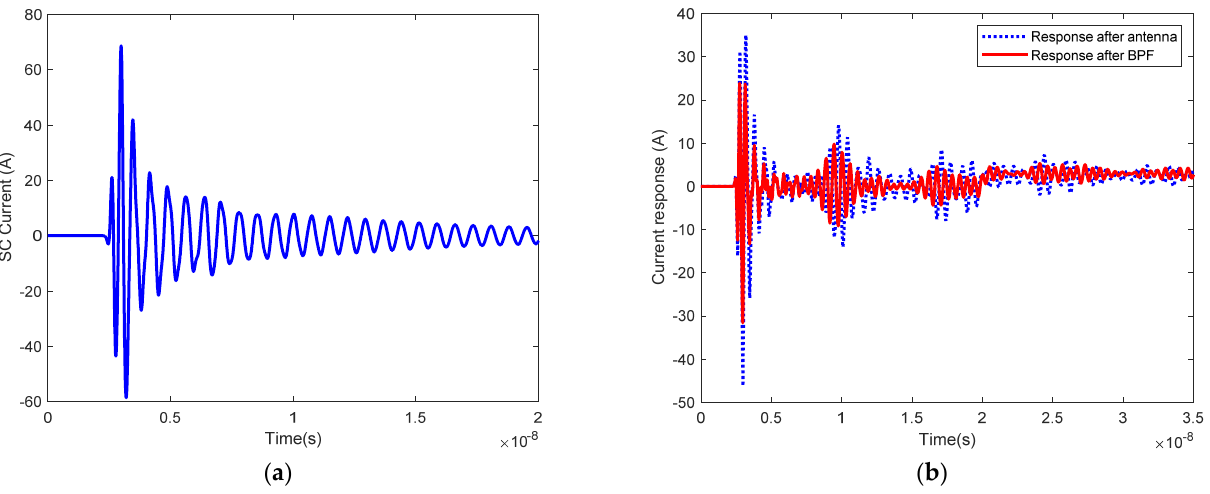
Figure 16. Coupling response excited by UWB: ( a ) Isc current; ( b ) Responses.